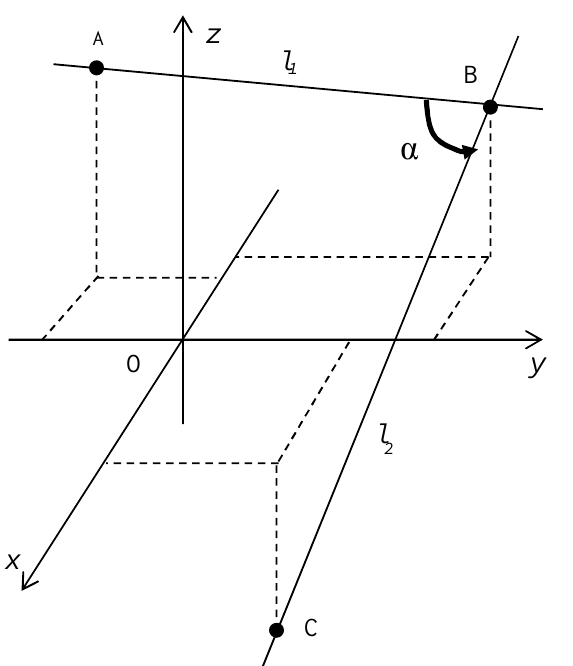
Figure 4. Angle ( α ) between lines l 1 and l 2 in 3-D space